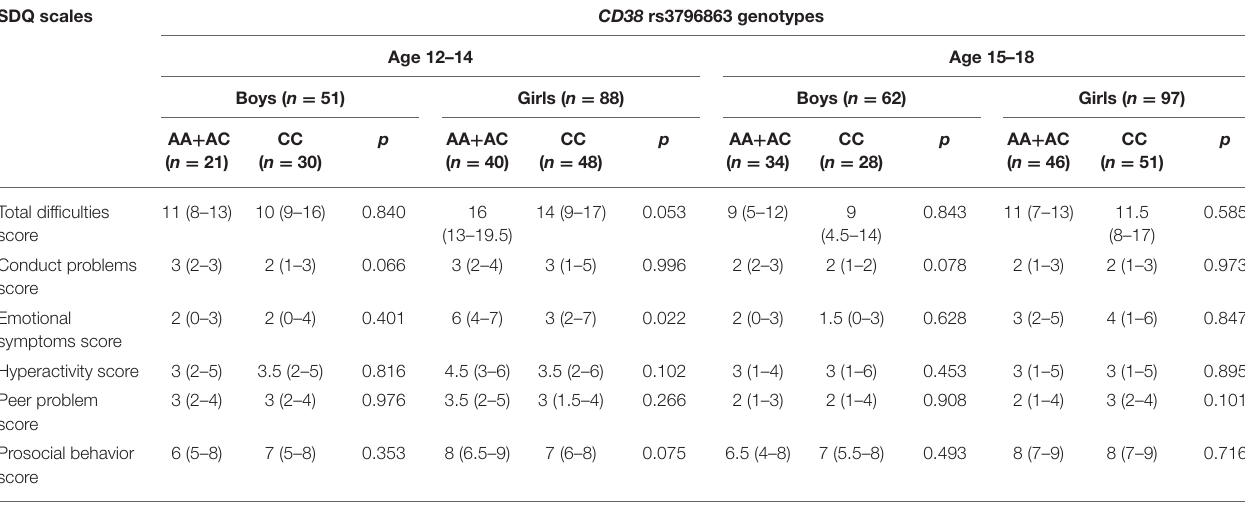
TABLE 3 | Values of the SDQ scales for the CD38 rs3796863 genotypes in different sex and age groups of adolescents. SDQ scales